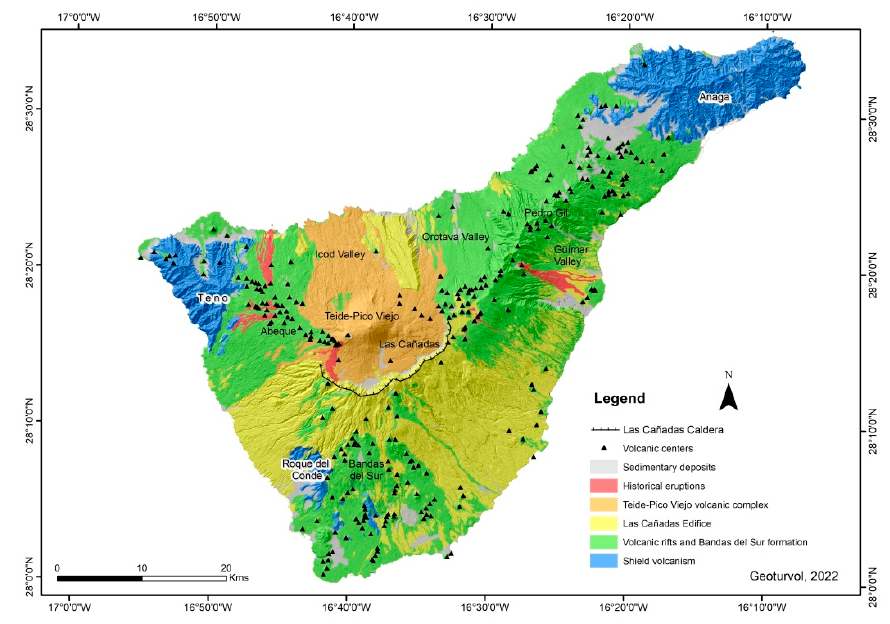
Figure 1. Geological simplified map of Tenerife. Source: IDE-Canarias-Grafcan. Self-elaboration.